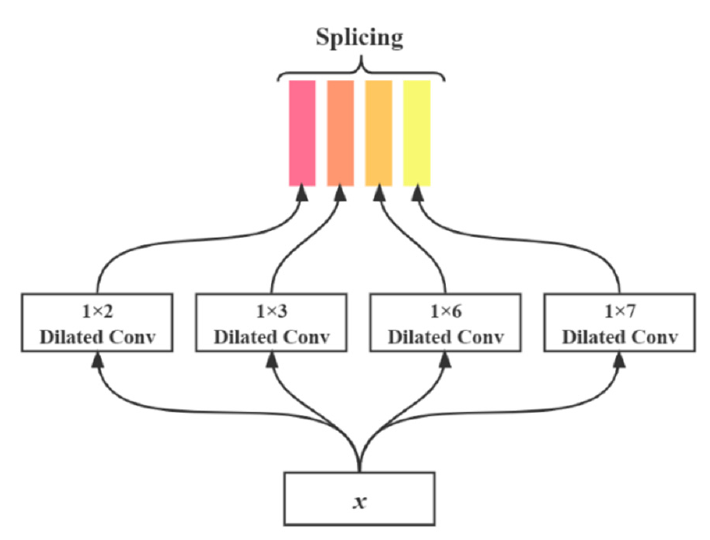
Figure 6. Dilated splicing